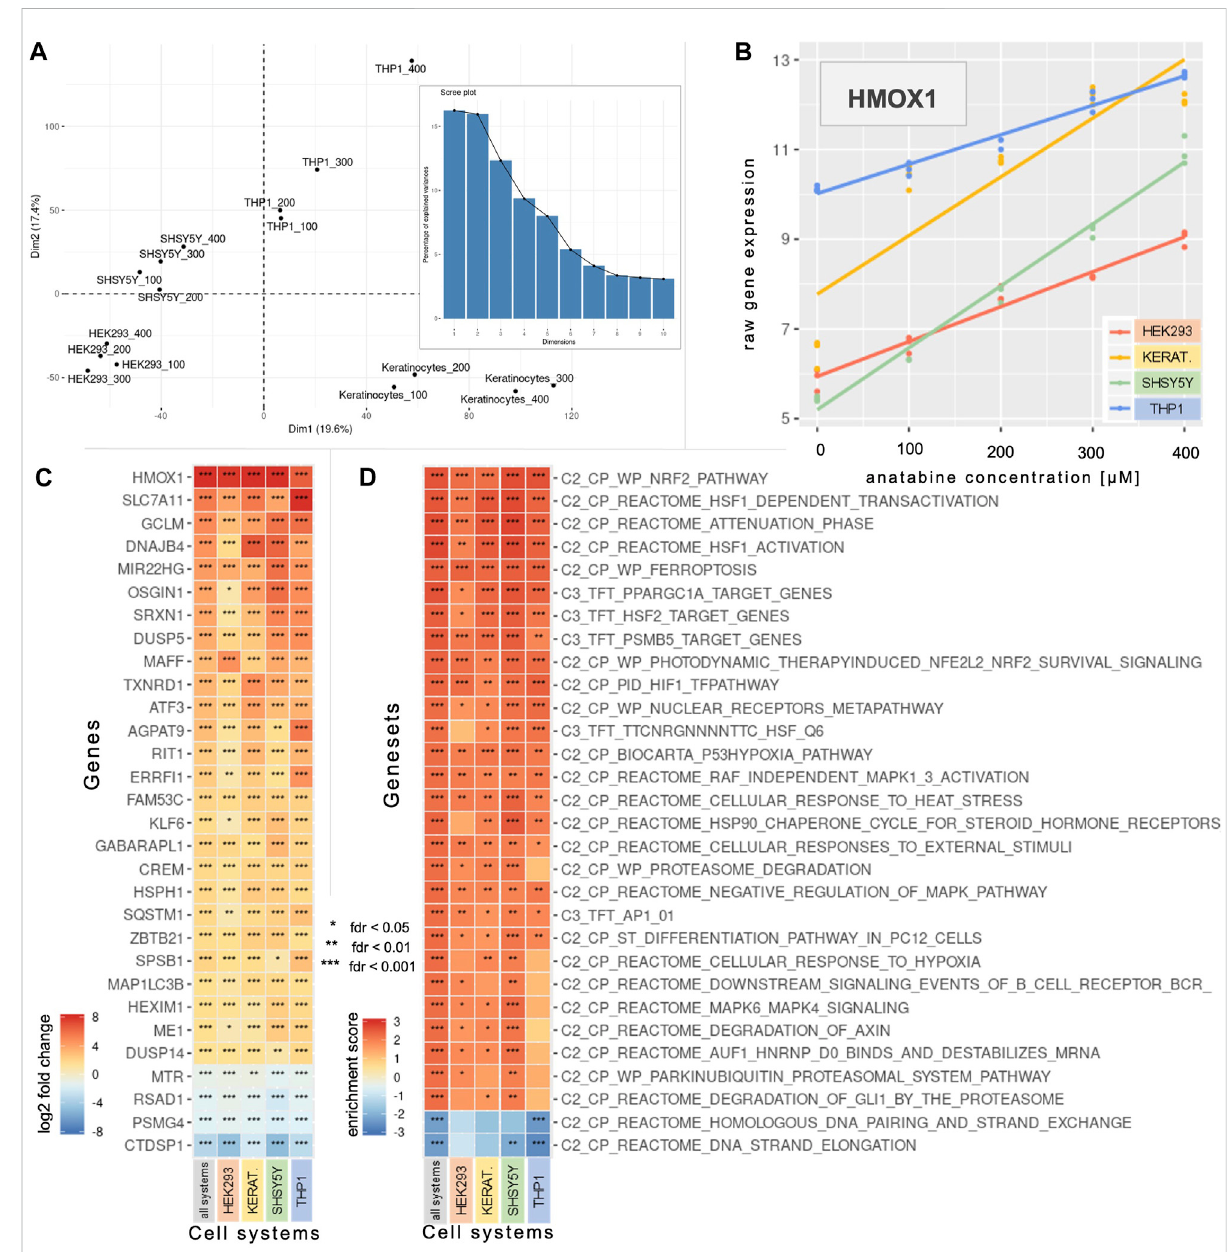
FIGURE 1 Concentration-dependent effect of anatabine on gene expression in various cell systems. (A) The two fi rst dimensions of a PCA across the four anatabine concentrations and the four tested cell systems. The bar plot depicts the percentage of variance explained by each principal component. (B) HMOX1 expressiondata acrossthetested anatabineconcentrations and cellsystems.The slope ofeachdepictedlinearmodel isthevalue thatdenotes modi fi cationsinthecorrespondinggeneexpressionwithincreasinganatabineconcentration. (C) The30mostsigni fi cantlyexpressedgenesbased on the “ all systems ” pro fi le (left column), which captures anatabine ’ s effect across all tested cell systems and concentrations. The other four columns correspond to the data for each cell system individually. Genes are ranked by median log2 fold change in each row. (D) The pro fi les of panel C are subjected to GSEA, and the 30 most signi fi cantly enriched gene sets based on the “ all systems ” pro fi le enrichment are presented here. Gene sets are ranked by median enrichment score in each row. PCA, principal component analysis; GSEA, gene set enrichment analysis; HMOX1 , heme oxygenase